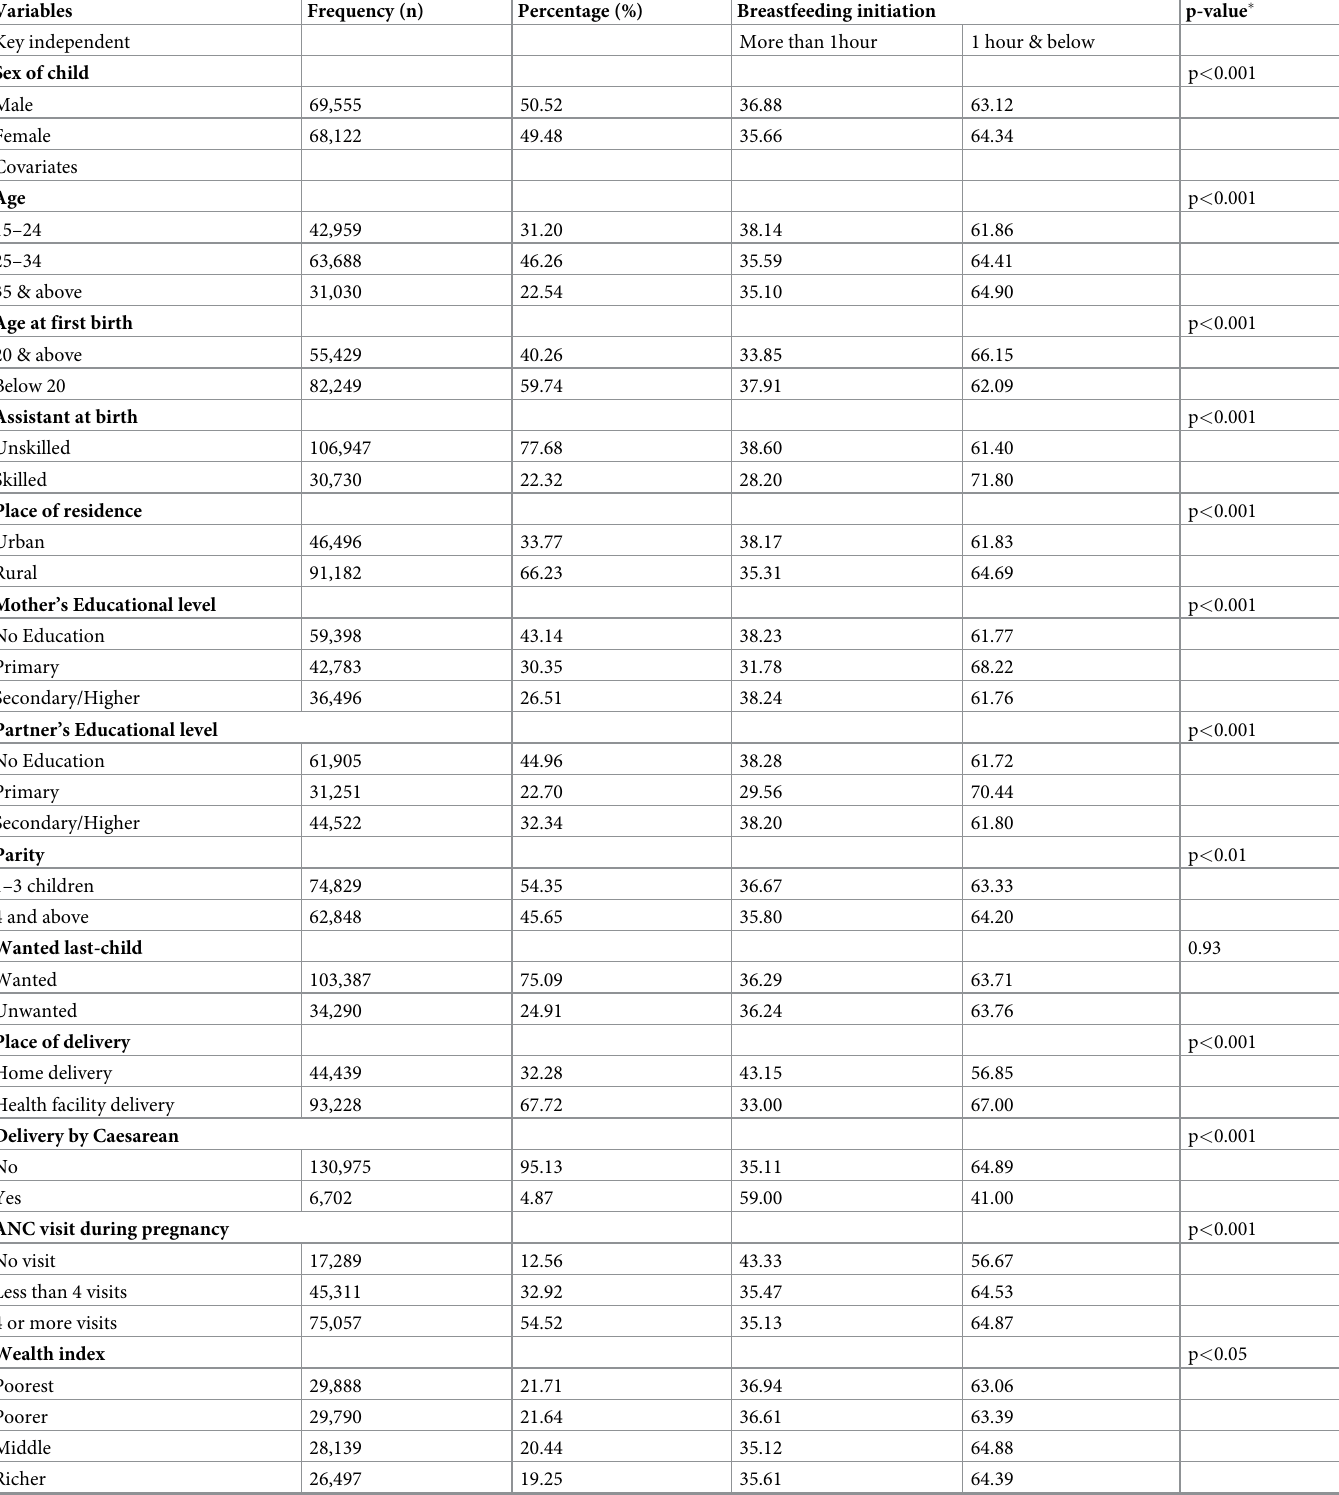
Table 2. Distribution of breastfeeding initiation among women by key independent variable and covariates (N =